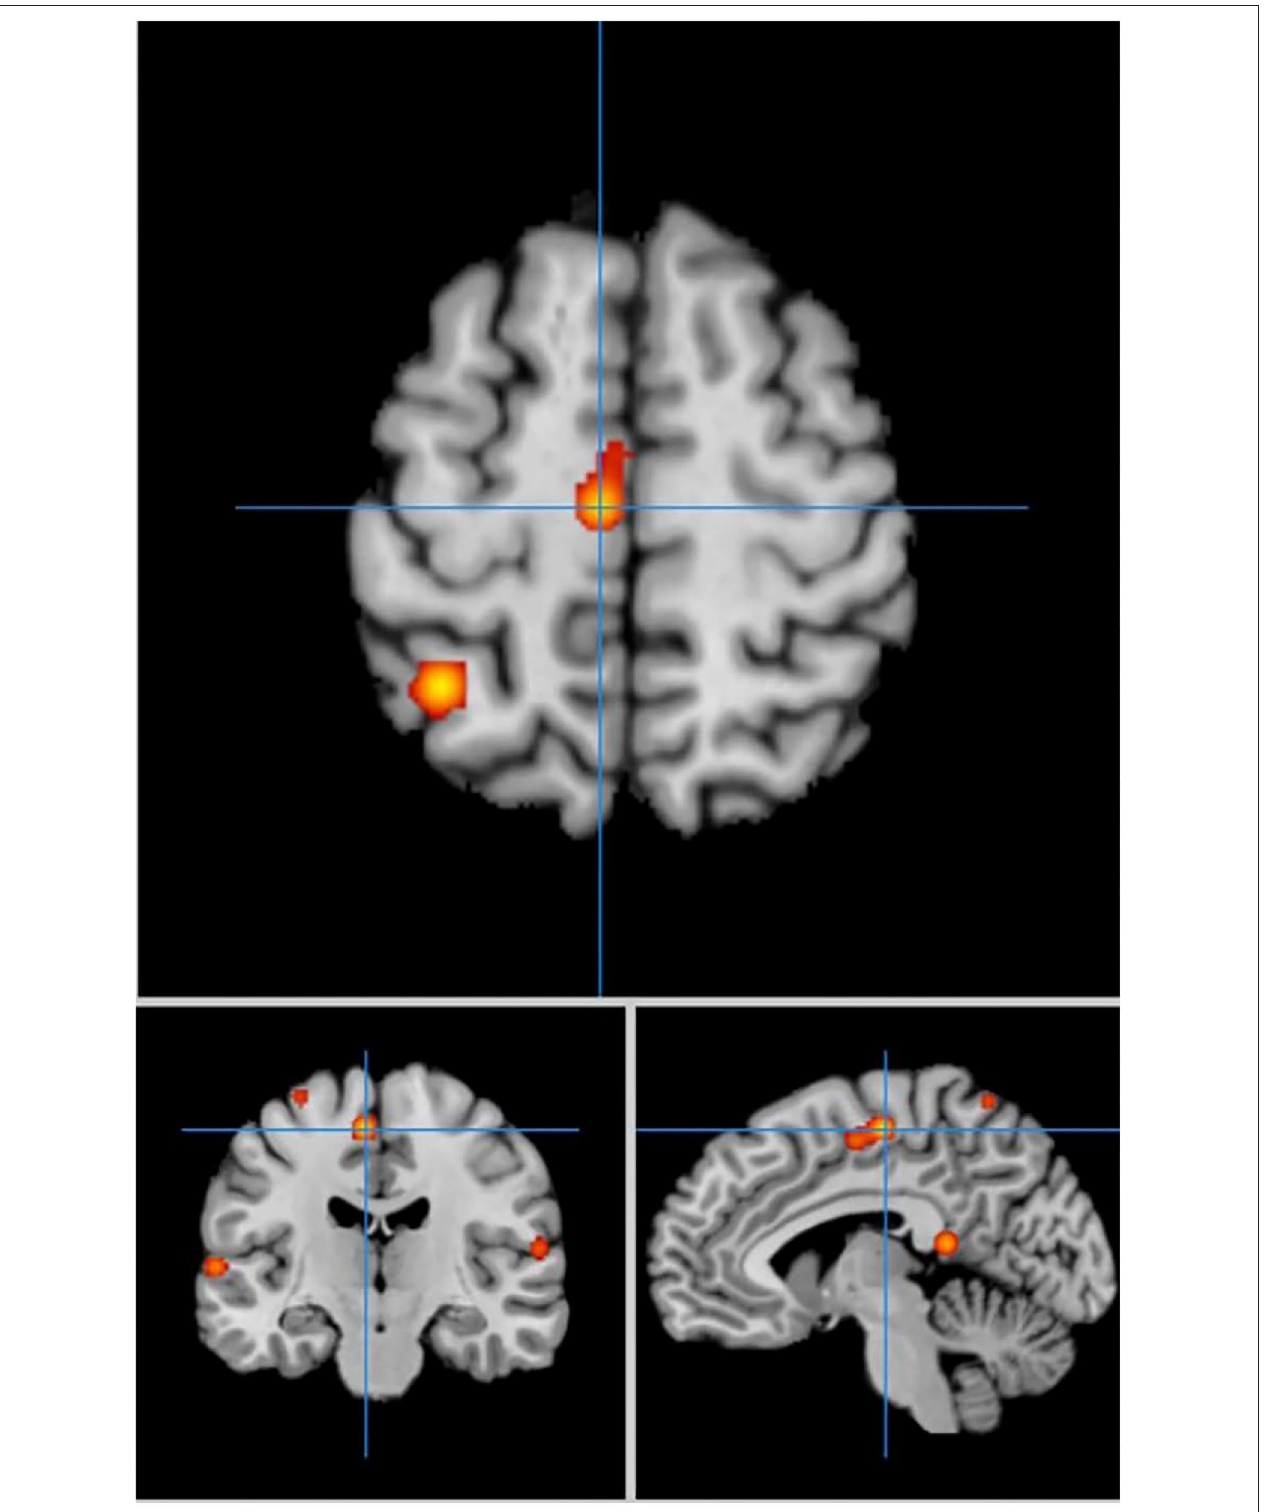
FIGURE 3 | Significant clusters in the ALE meta-analysis in cue-priming conditions in the PD patients.